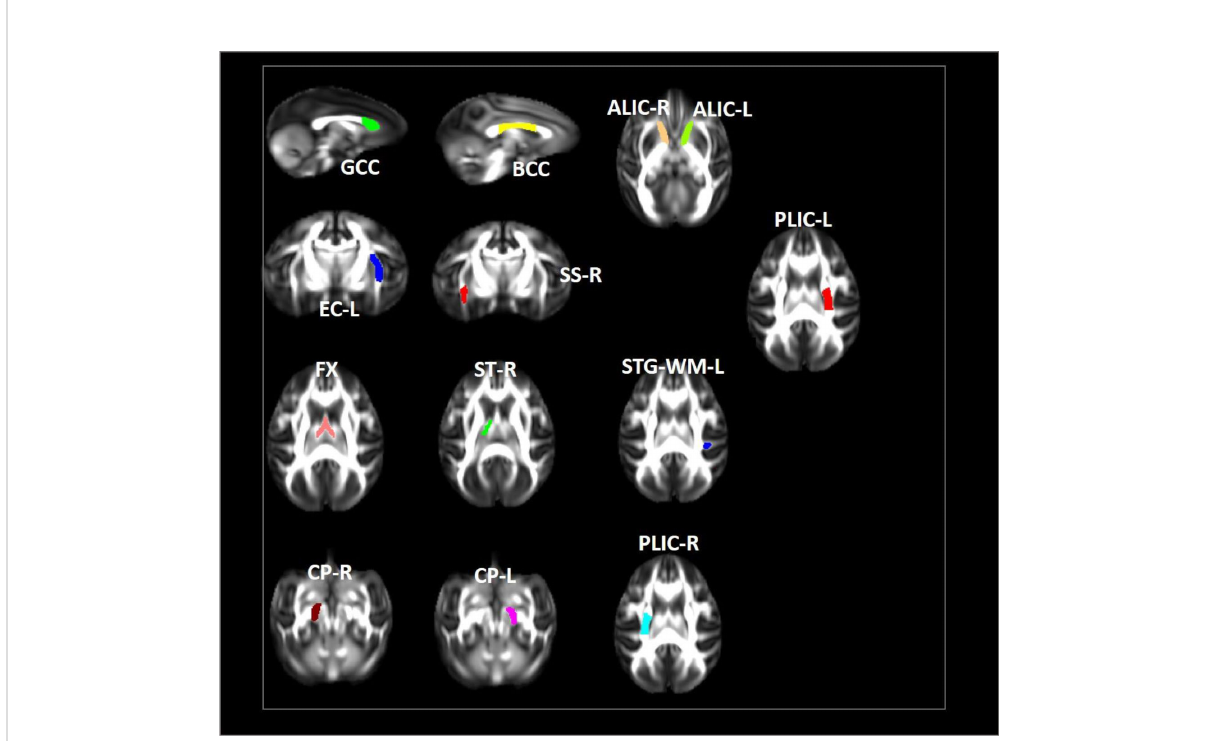
FIGURE 4 Changes in microstructures propagate differentially in SIV-macaques with and without antiretroviral therapy.